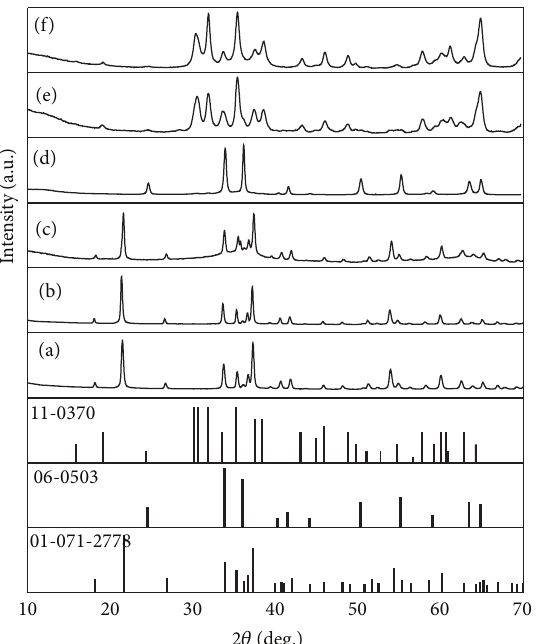
Figure 3: XRD diffraction pattern of GaO(OH) crystals precipitated from GaCl 3 solution with (a) NaOH, (b) NH 4 OH, and (c) decomposition of urea; XRD diffraction pattern of Ga 2 O 3 crystals after thermal conversion of GaO(OH) crystals hydrolysed with (d) NaOH, (e) NH 4 OH, and (f)